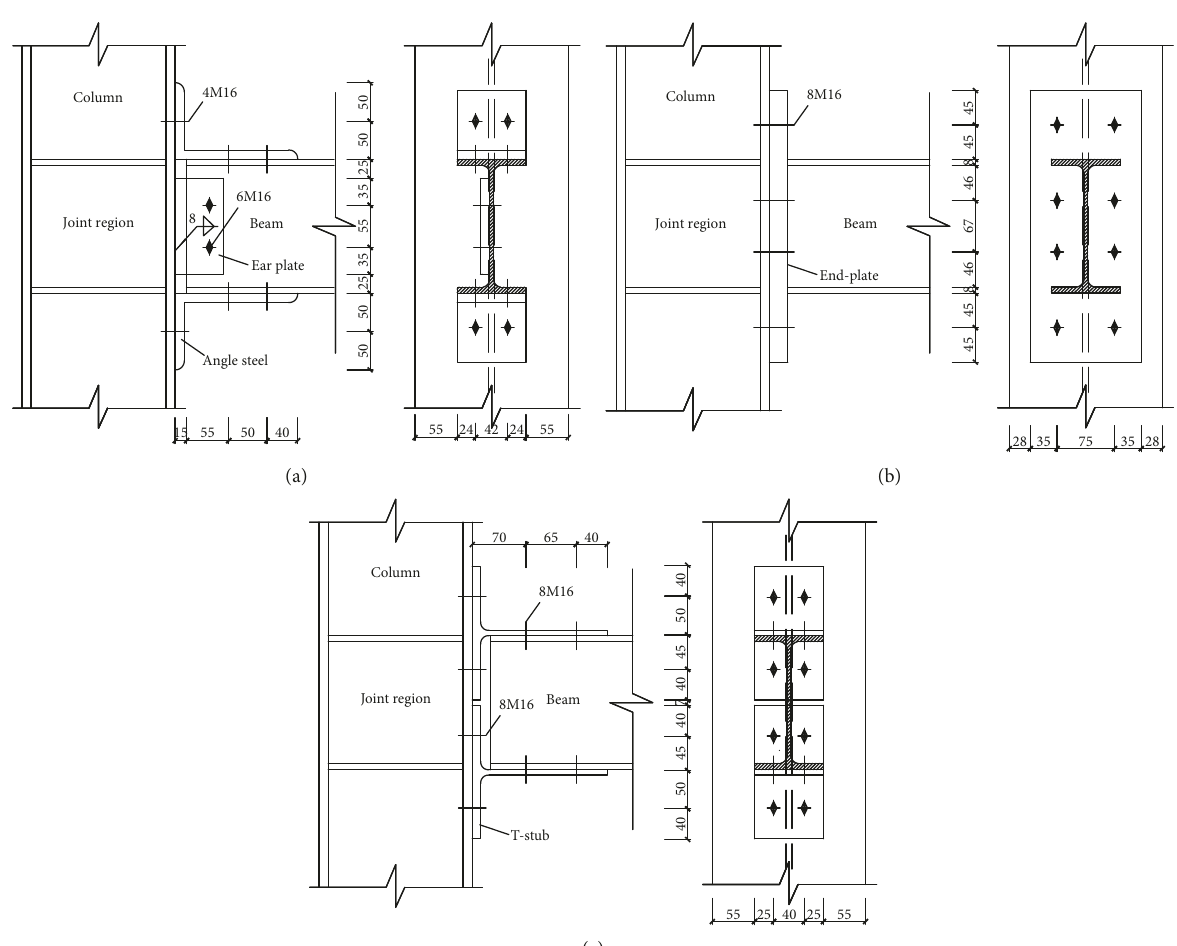
Figure 2: Forms of the semirigid connections. (a) J-1: top-seat angle connection with web and ear plates. (b) J-2: extended end-plate connection. (c) J-3: T-section